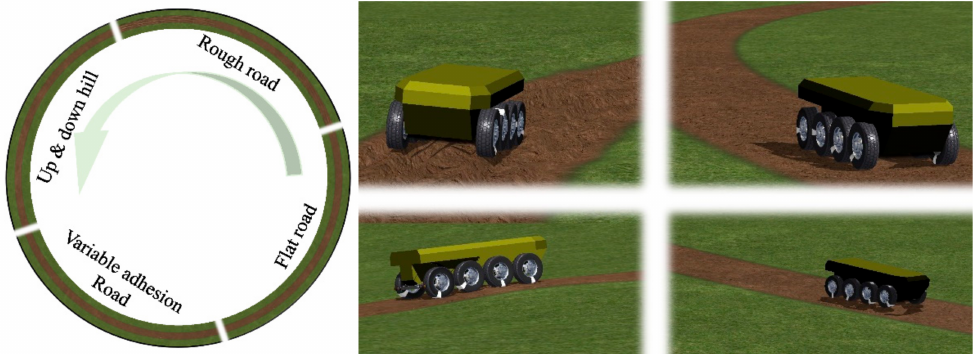
Figure 3. The off-road surface geometry partition.